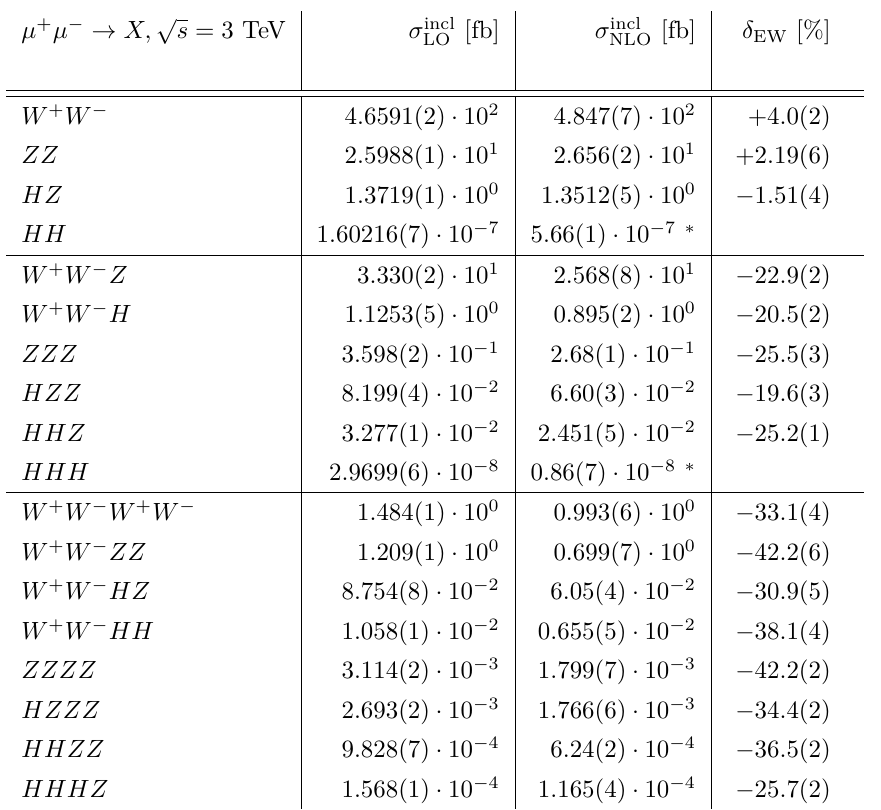
√ s = 3 TeV. For (*), with dominant loop-induced